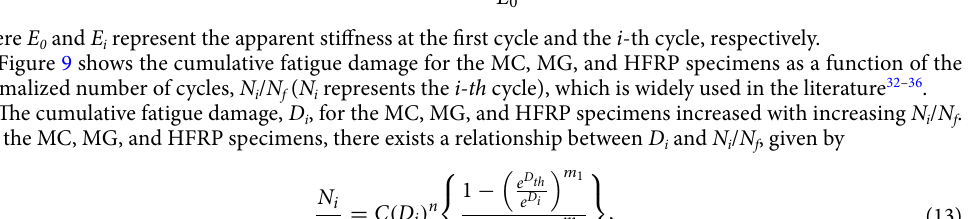
were approximately 5% higher than those of the HB specimen. For the HB, HC, HD, and HE specimens, the CFRP-dominant behavior of the fatigue properties decreased with increasing volume fraction of CFRP, and the GFRP-dominant behavior, which was lower than that of the estimated results, decreased with increasing volume fraction of CFRP. The CFRP-dominant behavior of the fatigue properties for the HE specimen was lower than that of the estimated results. On the other hand, for the HB, HF, HG, and HH specimens, the CFRP-dominant behavior of fatigue properties, which was higher than the estimated results, decreased with increasing volume fraction of CFRP. For the same specimens, the GFRP-dominant behavior, which was lower than the estimated results, increased with increasing volume fraction of CFRP. Fatigue damage, such as matrix cracking and delamination, often results in a significant reduction in the modulus of composite laminates. Hence, it is crucial to develop an analytical model to describe the cumulative damage of composites due to fatigue based on apparent stiffness reduction 32–36 . Figure 8 shows apparent stiff- ness reduction during fatigue loading (low, middle, and high stress levels) for the mono CFRP and GFRP and HFRP specimens. Most of the stiffness reduction occurred in the earlier stages of fatigue life, whereas the damage density increased steeply. The rate of stiffness degradation became very low as soon as the damage density reached a saturated value. The stiffness reduction trends of the HA, HB, HC, HD, and HE specimens were similar to those of the MC specimen. The stiffness reduction trends of the HF, HG, and HH specimens were similar to those of the MG specimen. Stiffness reduction reflects the damaged state under fatigue cycles after the distribution of damage for the MC, MG, and HFRP specimens. The cumulative fatigue damage 30–34 for the MC, MG, and HFRP specimens, D i , is defined as